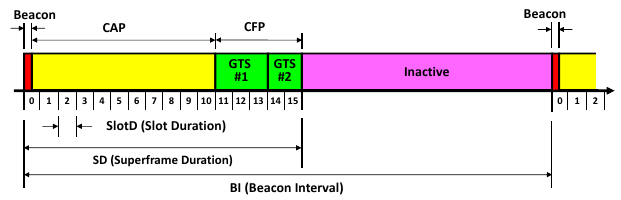
Figure 2: The IEEE 802.15.4 superframe structure for the beacon enabled mode.